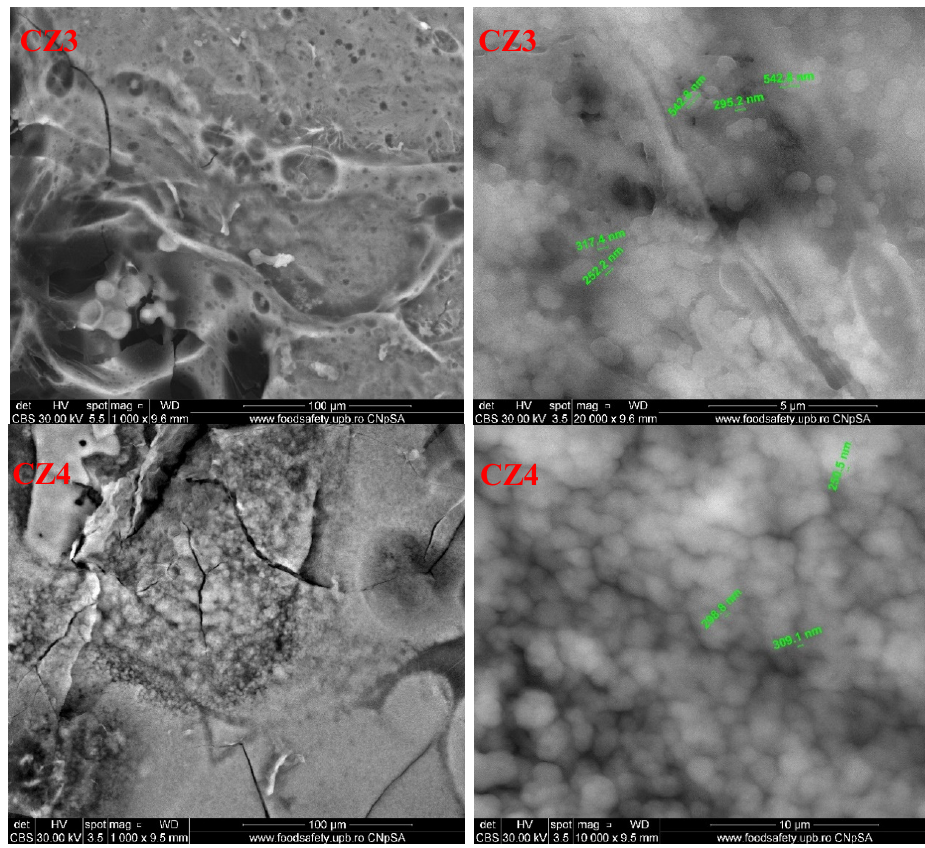
Figure 11. The SEM images for chitosan, CZ1, CZ2, CZ3, and CZ4 films.